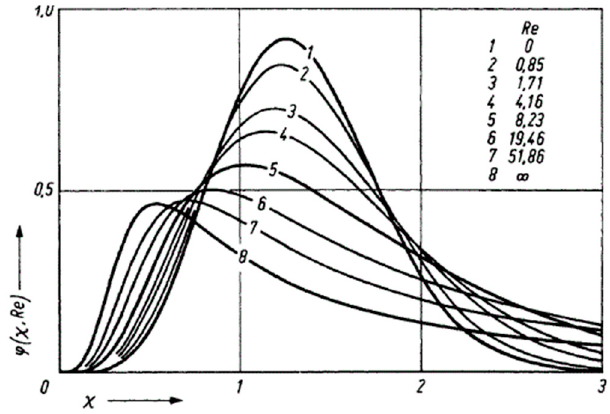
Figure 5. Energy spectra for different Reynolds numbers according to Rotta [10]; reproduced with permission of Springer.